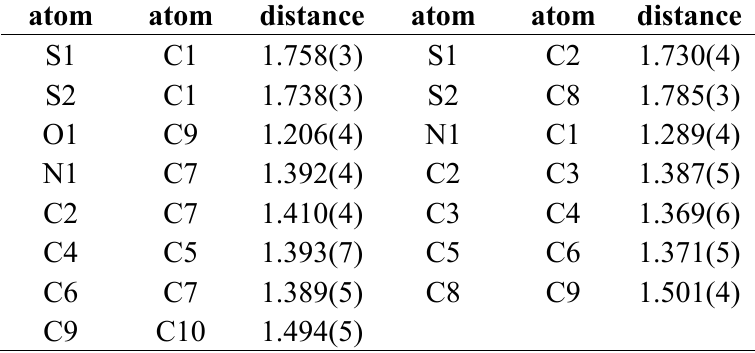
Table 7. Bond lengths (Å) for compound 5